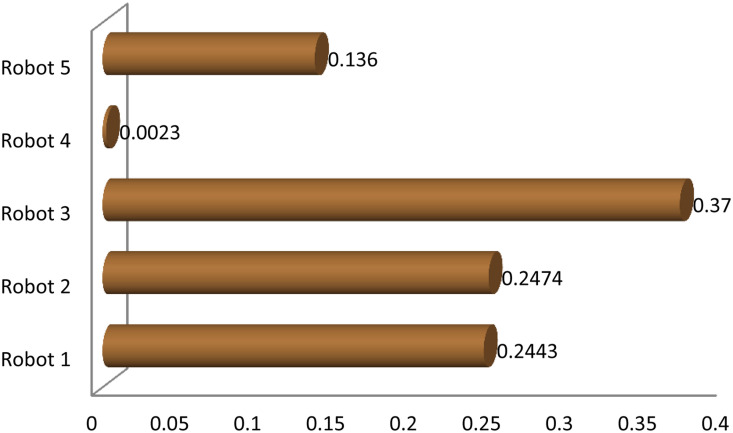
Sensitivity analysis of the criteria C2.